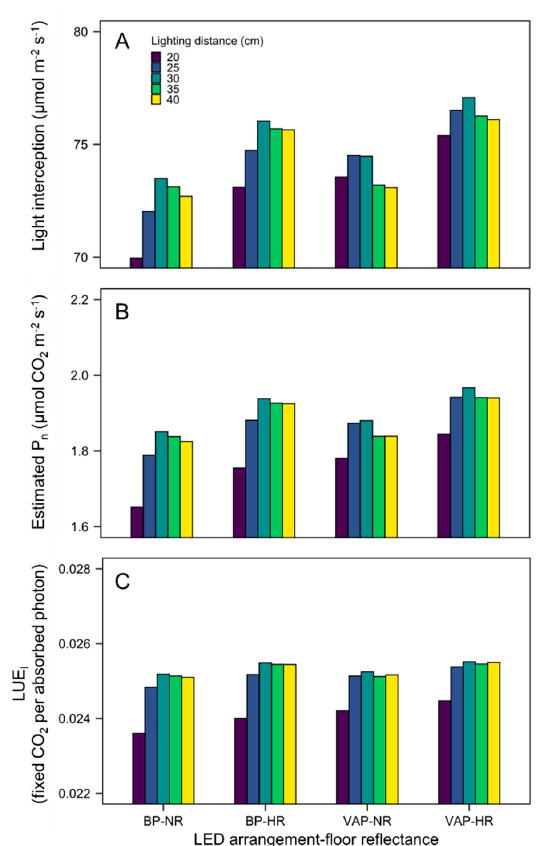
Figure 10. Light interception ( A ), estimated net photosynthetic rate ( B ), and light use efficiency for intercepted light (LUE I ) ( C ) at different light arrangements, lighting distances, and floor reflectances. Light sources were arranged vertically above the plant (VAP) or between the plants (BP). Floor surface was set at non-reflective (NR) or high-reflective (HR) material.